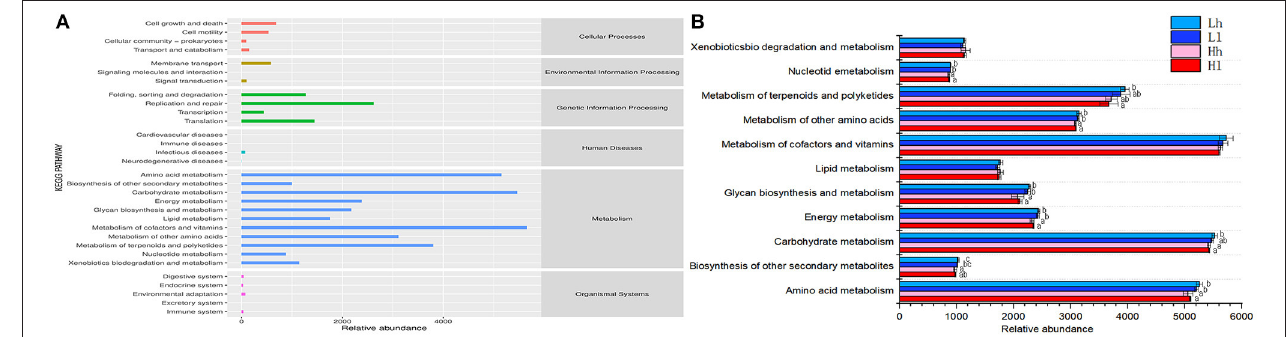
FIGURE 10 | (A) Predicted KEGG secondary functional pathway abundance map. The abscissa is the abundance of the functional pathway (unit: KO per million), the ordinate is the functional pathway of the second classification level of KEGG, and the rightmost is the first-level pathway to which the pathway belongs. Shown here is the average abundance of all samples. (B) Comparison of rumen microbial KEGG. Significantly different modules in each significantly different level 2 pathway (Lh, light blue; Ll, navy blue; Hh, pink; Hl, red) were